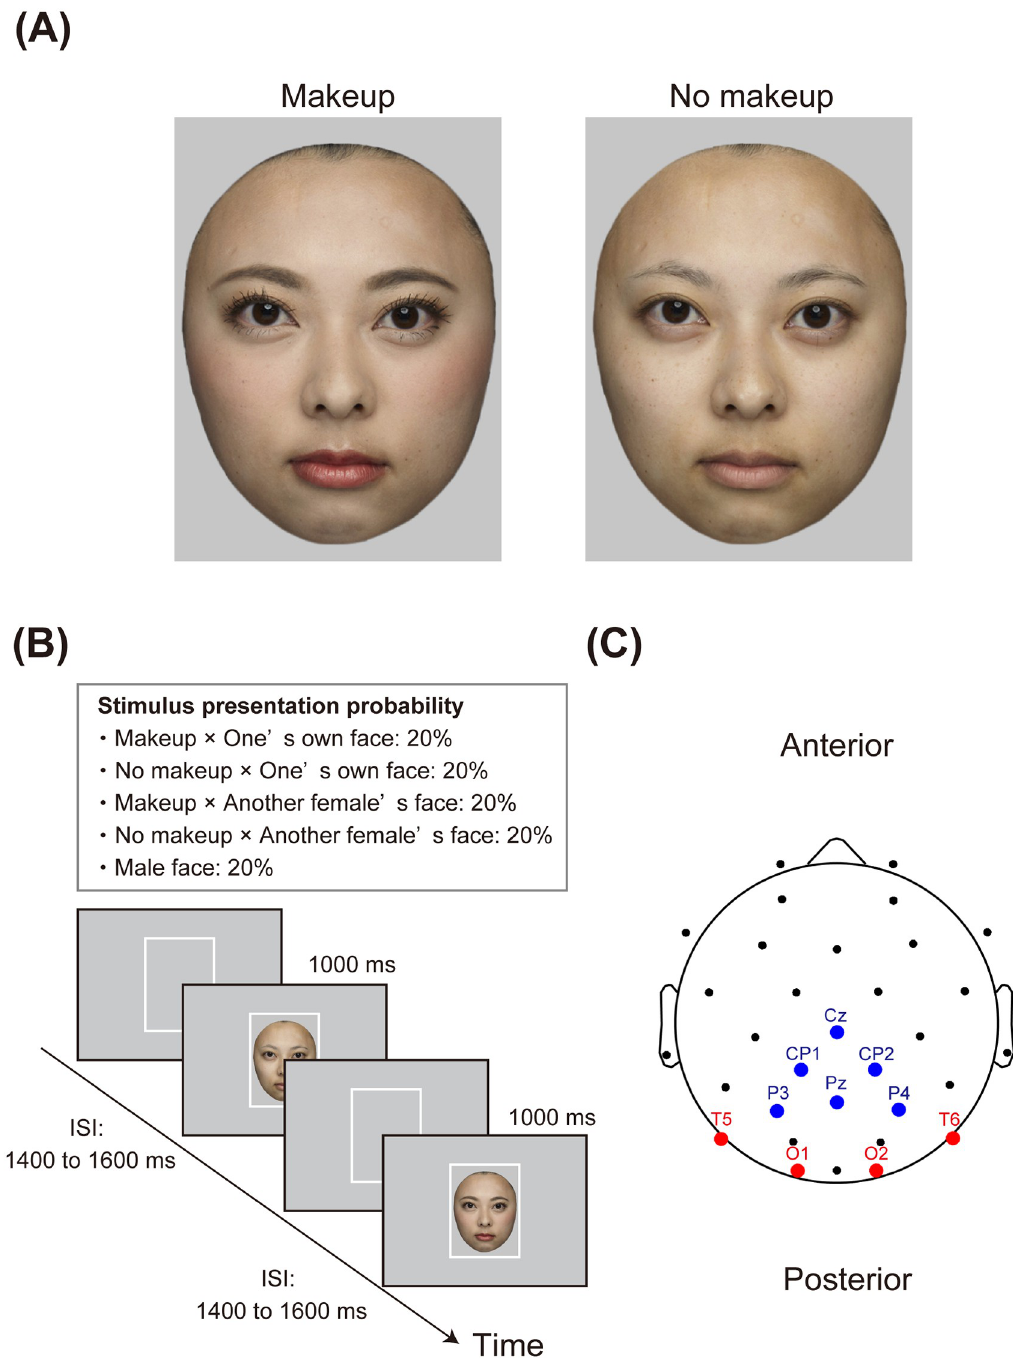
Fig 3. Stimuli and procedures in Experiment 2. Panel A depicts an example of facial images. The individual in this figure has given written informed consent to publish her facial images. Panel B illustrates a schematic representation of the gender classification task. Panel C shows the EEG sensor layout and ROIs. The electrodes included in the occipitotemporal ROI are marked in red, and the blue circles indicate electrodes located in the centroparietal ROI. EEG, electroencephalogram; ROI, region of